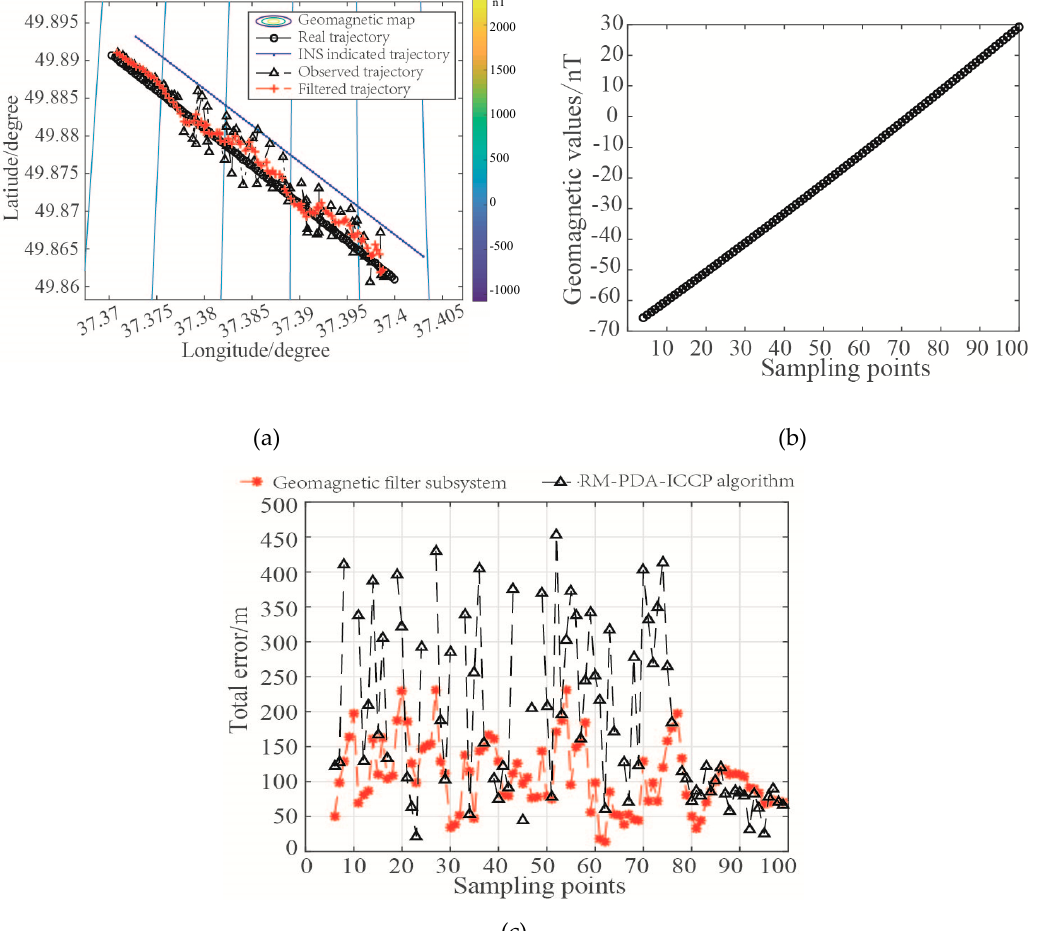
Figure 8. Filtering results of the geomagnetic filter subsystem: ( a ) Filtering trajectory of geomagnetic filter subsystem; ( b ) The magnetic values along the trajectory; ( c ) Total filtering error of geomagnetic filter subsystem.